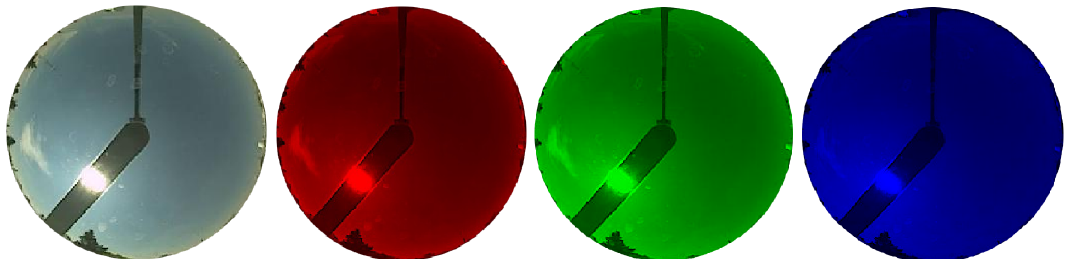
Figure 2. Extraction of the red, green and blue channel from the image (20160219201700: 19 February 2016—20:17:00 UTC.). The white color of the clouds stands out more when viewed through the image’s red channel